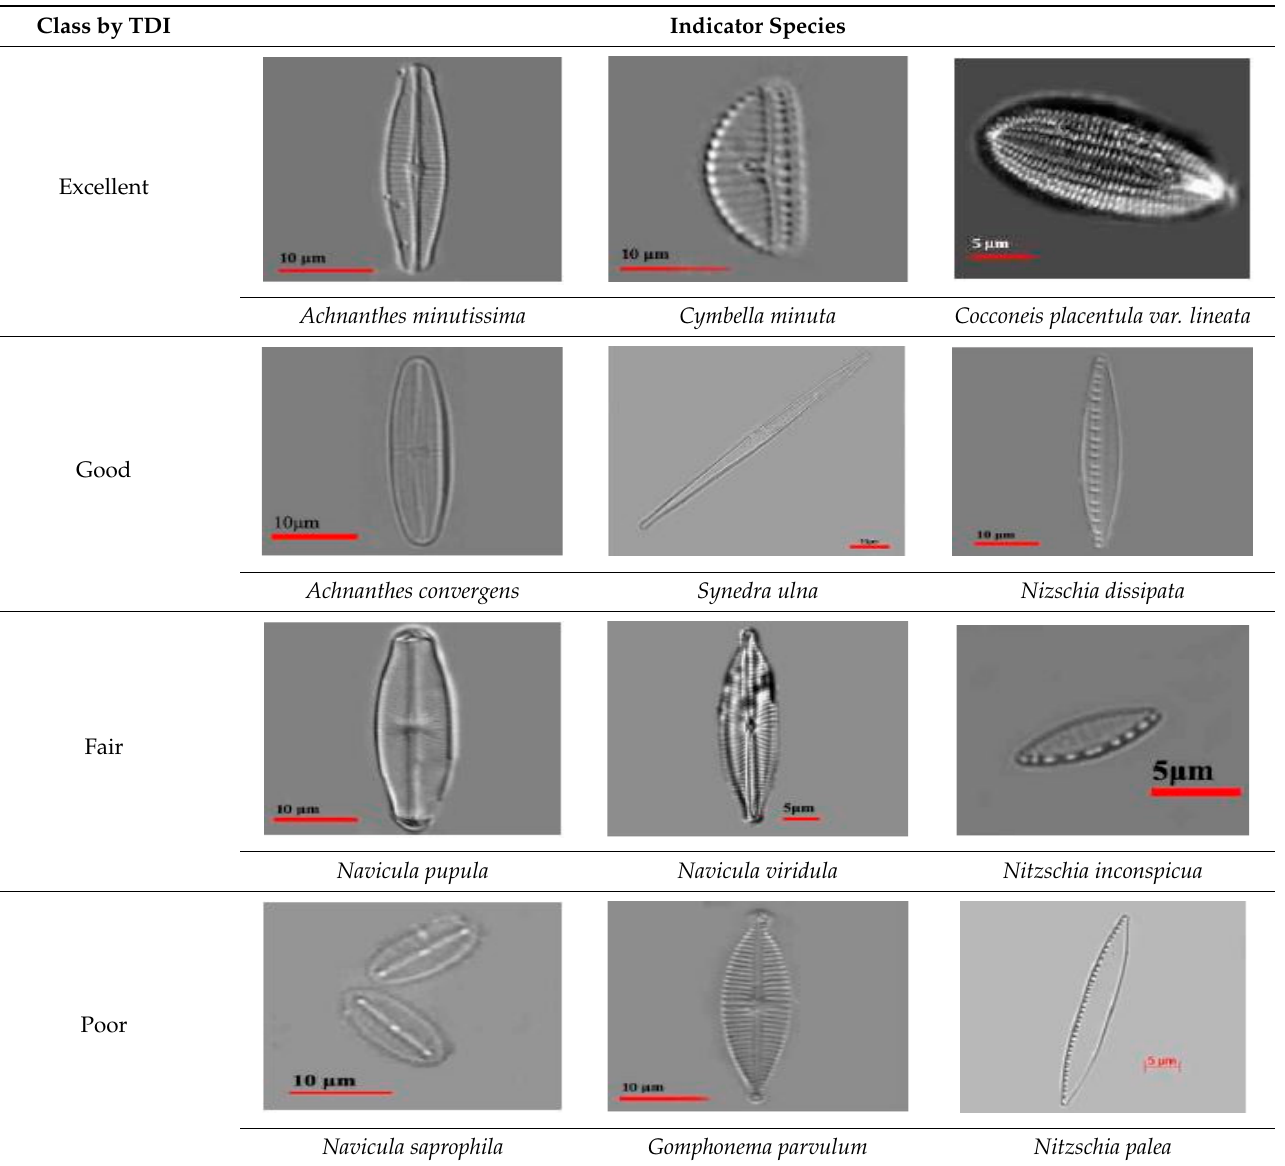
Table 9. Determination of biological grade using epilithic diatoms in ecological river restoration technical guide, Korea Ministry of Environment [23,36].